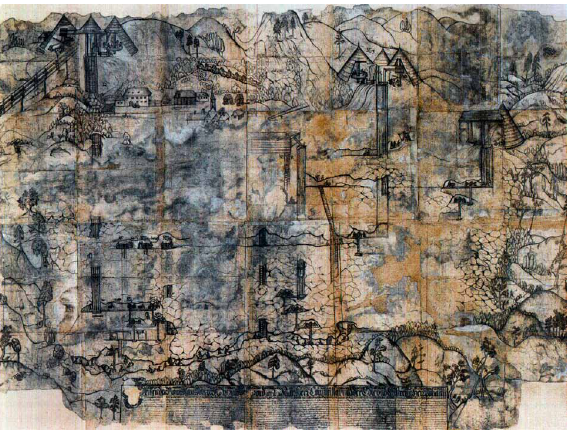
Fig. 4. The oldest map of the Head Komorsky Grof